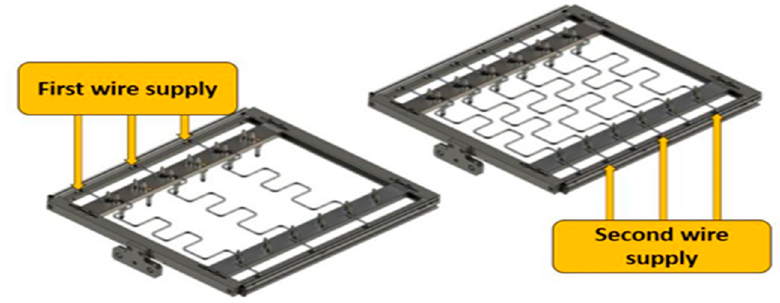
Figure 5. Drawer system with the positioning jig for the wires.